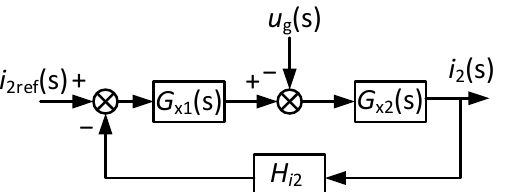
Figure 7. Simplified block diagram of the GCI control system with capacitor current proportional feedback.